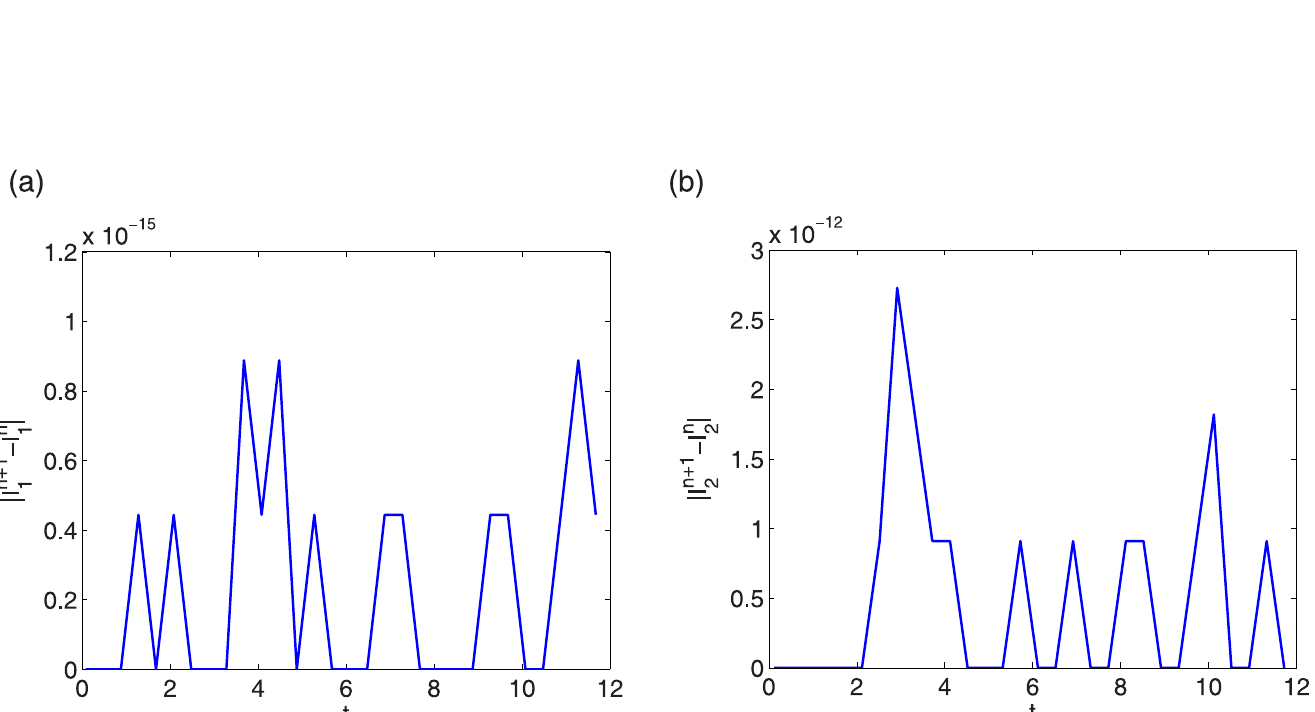
Fig 13. Errors of discrete energy I n